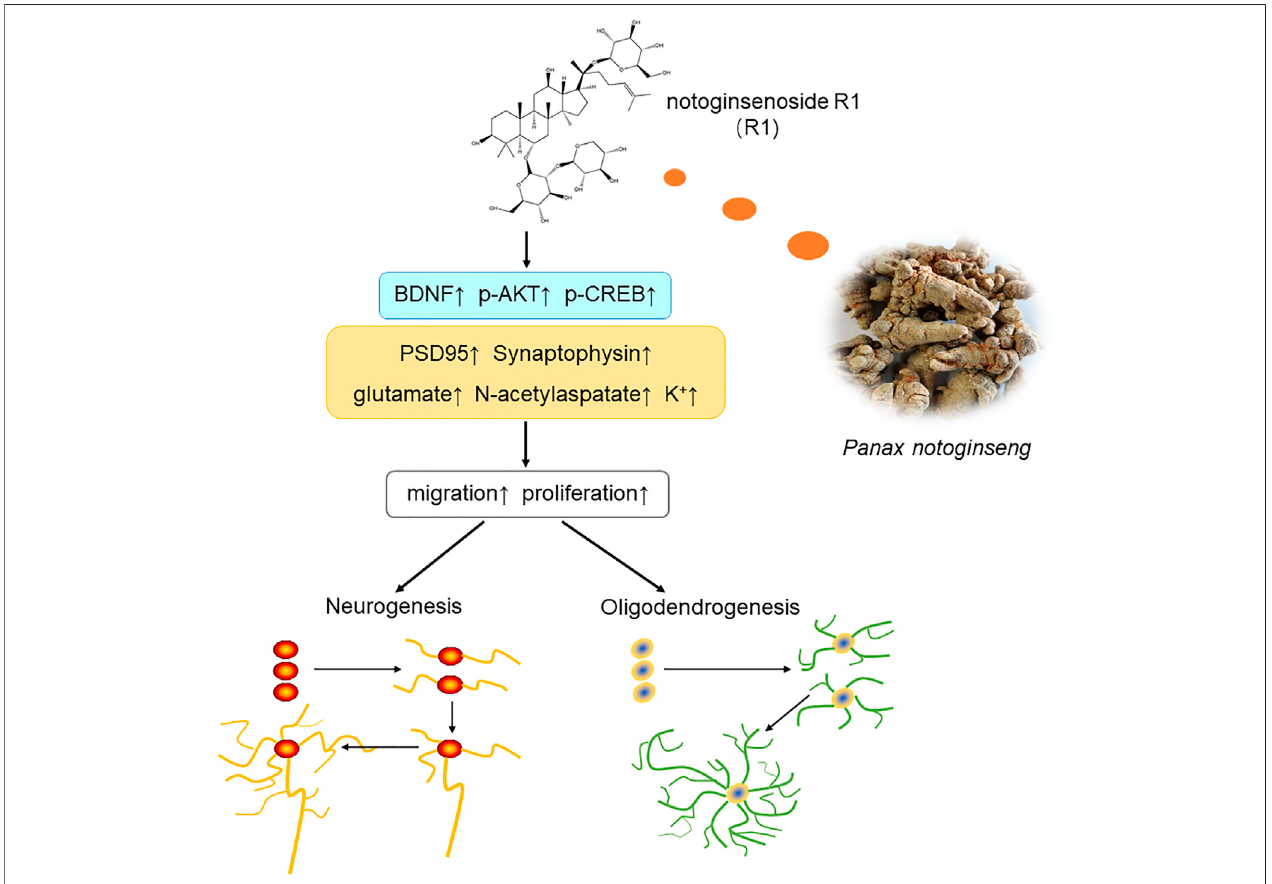
FIGURE 9 | Schematic diagram of the mechanisms underlying the R1-induced promotion of neurological recovery after ischemia-reperfusion injury. Overall, R1 enhances neurogenesis and oligodendrogenesis by promoting NPC proliferation, migration and the survival of newborn neurons. Therefore, R1 stimulates the expression of neural synaptic factors and facilitates the release of neurotransmitters. R1 activates the BDNF/Akt/CREB signaling pathway, thereby accelerating neurogenesis to promote neurological recovery.